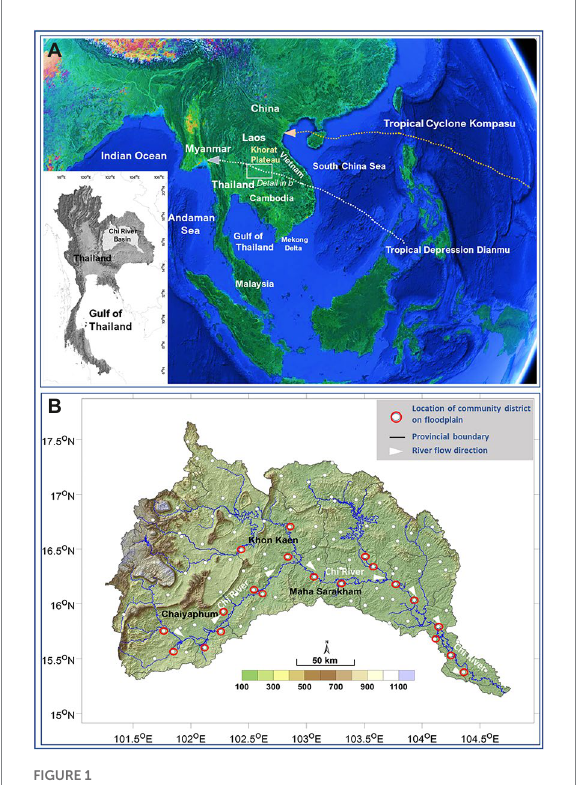
FIGURE 1 Maps showing the location of the Khorat Plateau in mainland Southeast Asia and the geographical names referred to in this brief report. (A) The Chi River catchment basin is found in northeast Thailand (grey shaded area in left corner index map), storm tracts of Dianmu and Kompasu (dashed lines with triangle direction of the storm). (B) Digital Elevation Model (DEM) of the Chi River catchment basin showing the upstream part from the highlands in the western part. The river flows in a northeastern direction (white arrow) covering the southern part of Chaiyaphum, extending to Khon Kaen, and then flows in a southeast